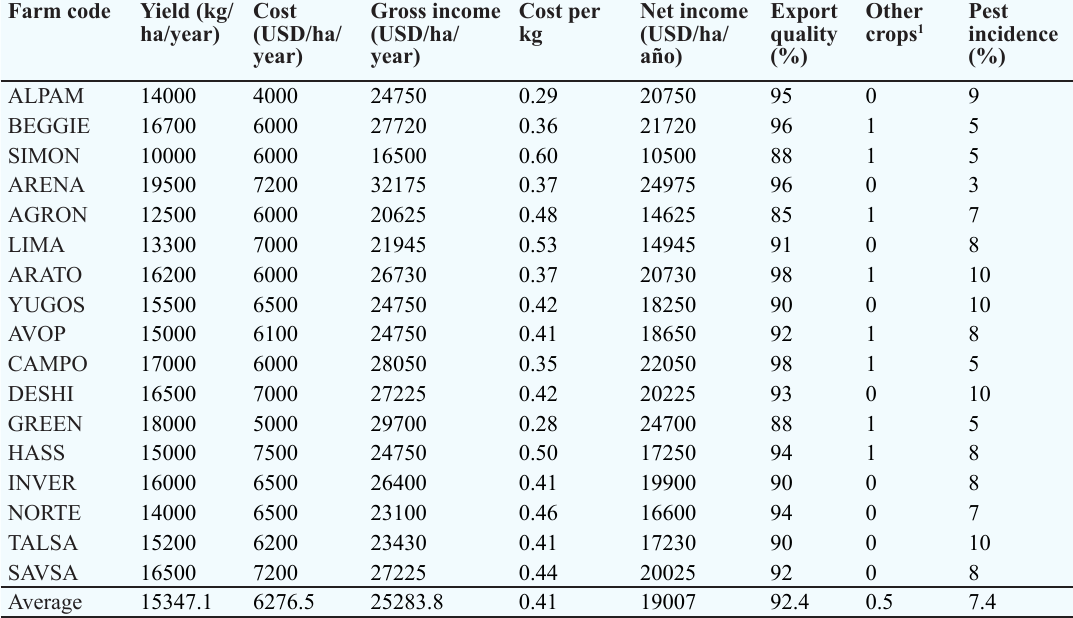
Table 5. Economic indicators of the avocado farms of the Chavimochic irrigation project in December 2017. Farm code